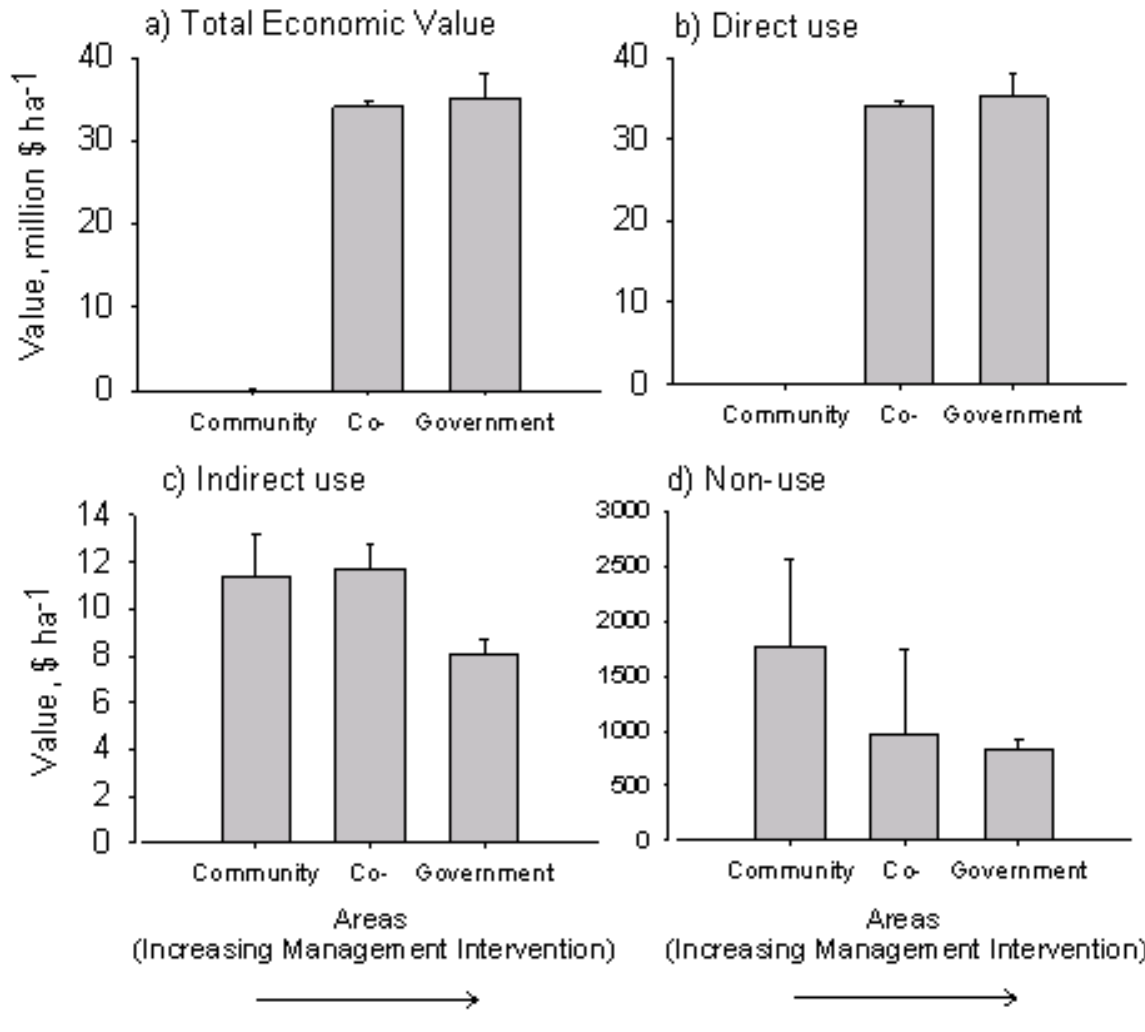
Fig. 2. Differences in total, direct, indirect, and non-use values across the three management areas